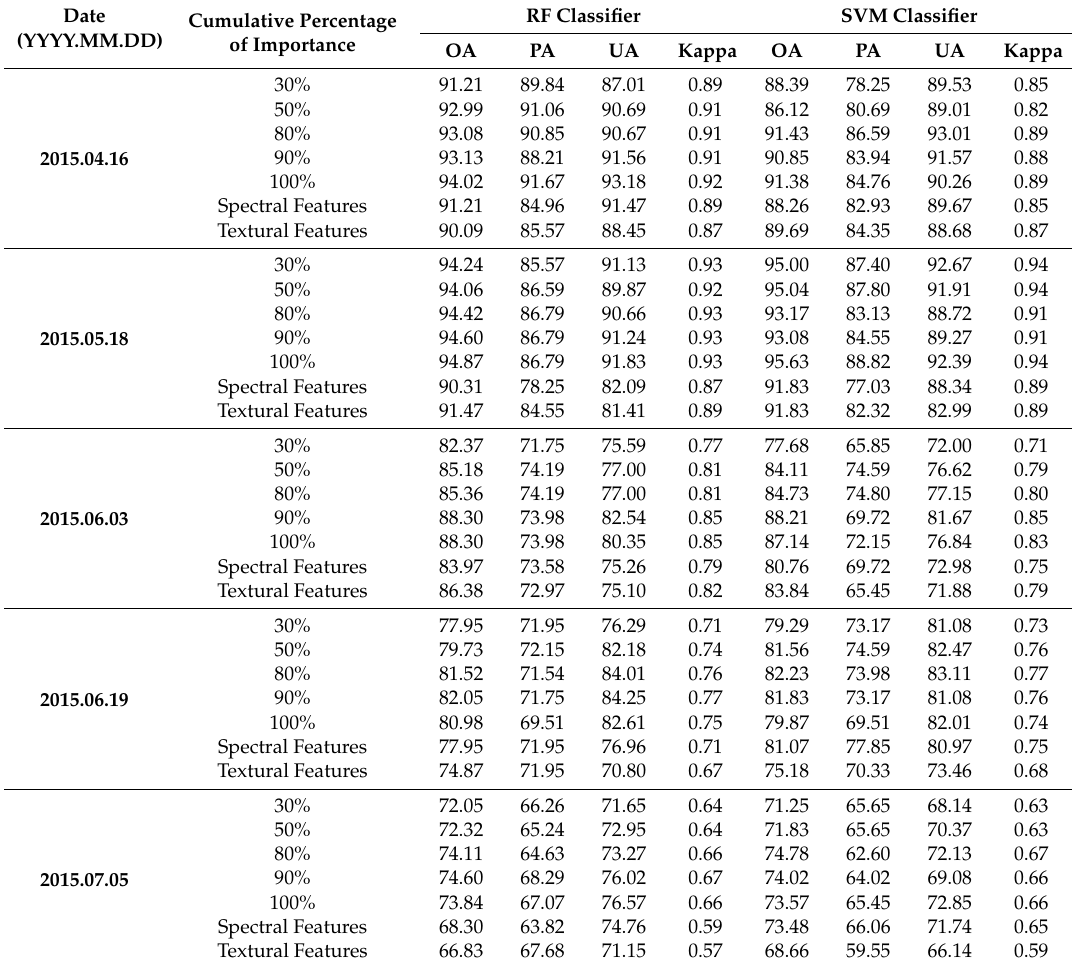
Table 5. The mapping accuracies generated from RF using different features in Jizhou. OA: overall accuracy; PA: producer’s accuracy; UA: user’s accuracy.